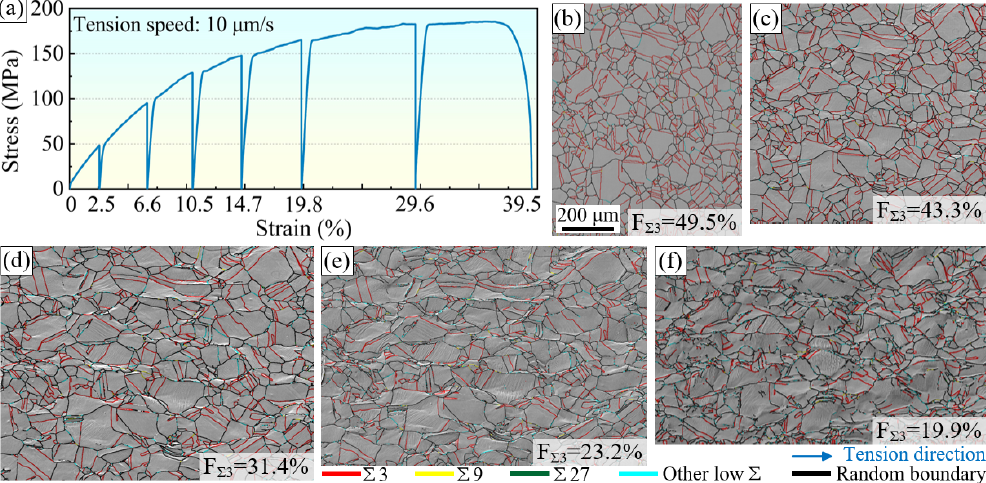
Figure 2. ( a ) Stress–strain curve of the nickel wire during quasi in situ tensile test, ( b – f ) SEM and GBCD diagrams at strains of 0, 10.5%, 19.8%, 29.6%, and 39.5%, respectively.